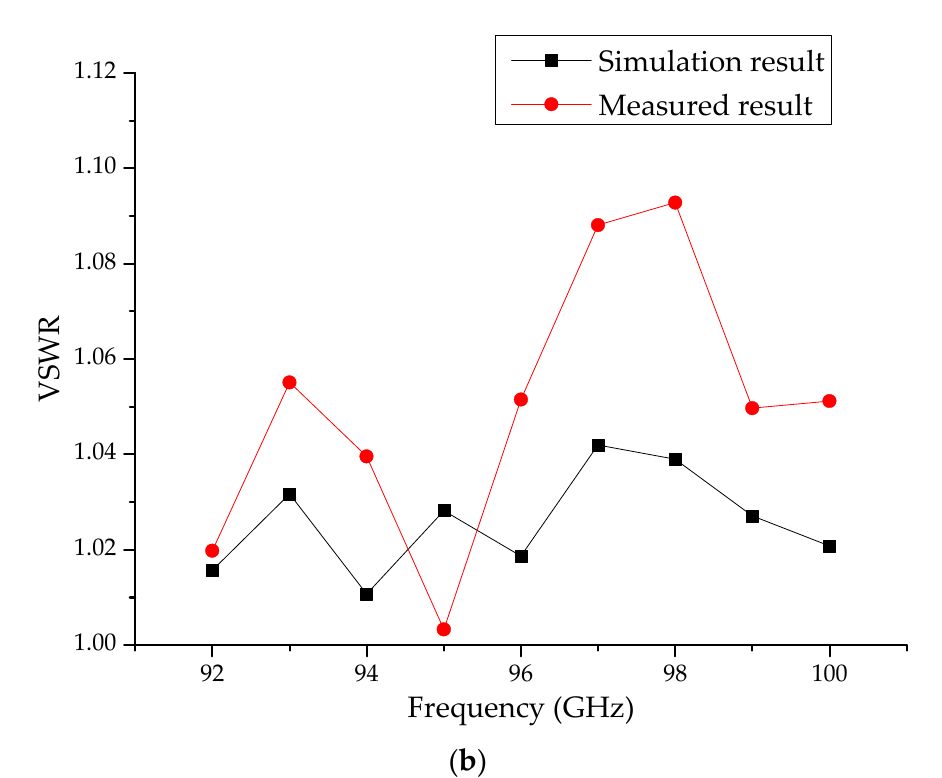
Figure 12. Cold test results of the critical components of the W-band gyro-TWT. ( a ) Input coupler; ( b ) Output window. The prototype of the W-band TE 02 mode gyro-TWT is shown in Figure 13. The length and maximum diameter of the tube are 1400 mm and 85 mm, respectively.